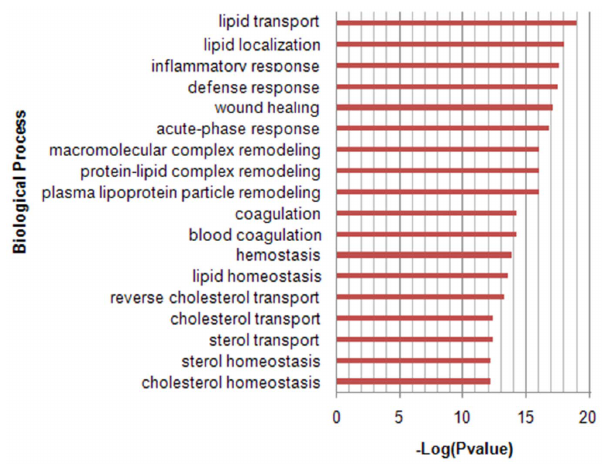
Figure 2. Gene ontology (GO) analysis of the 196 HDL- associated proteins for classification by biological process. According to the GO database, the main biological functions of the 196 proteins are shown with their enrichment score, represented as a P -